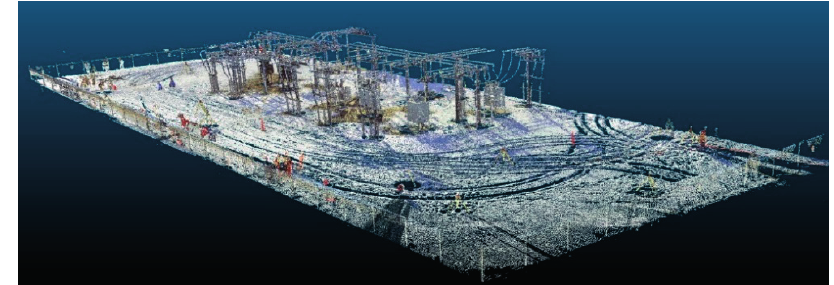
Figure 18. Second dataset, scanned by a Faro Focus terrestrial laser scanner.